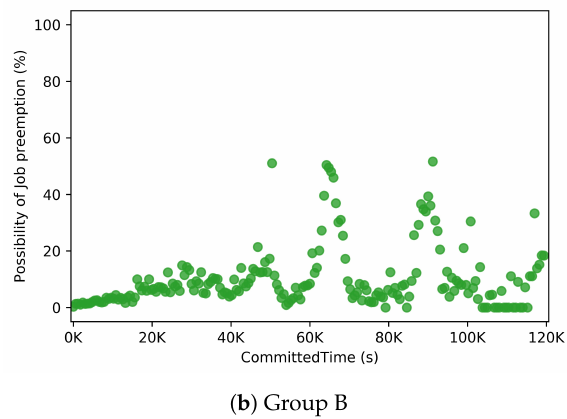
Figure 10. Probability of preempted jobs by committed time.